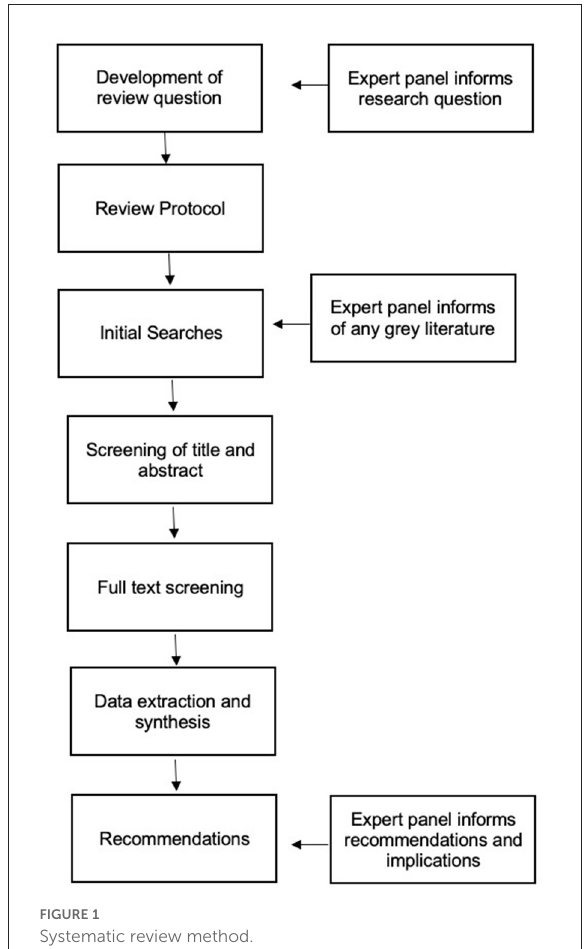
FIGURE1 Systematic review